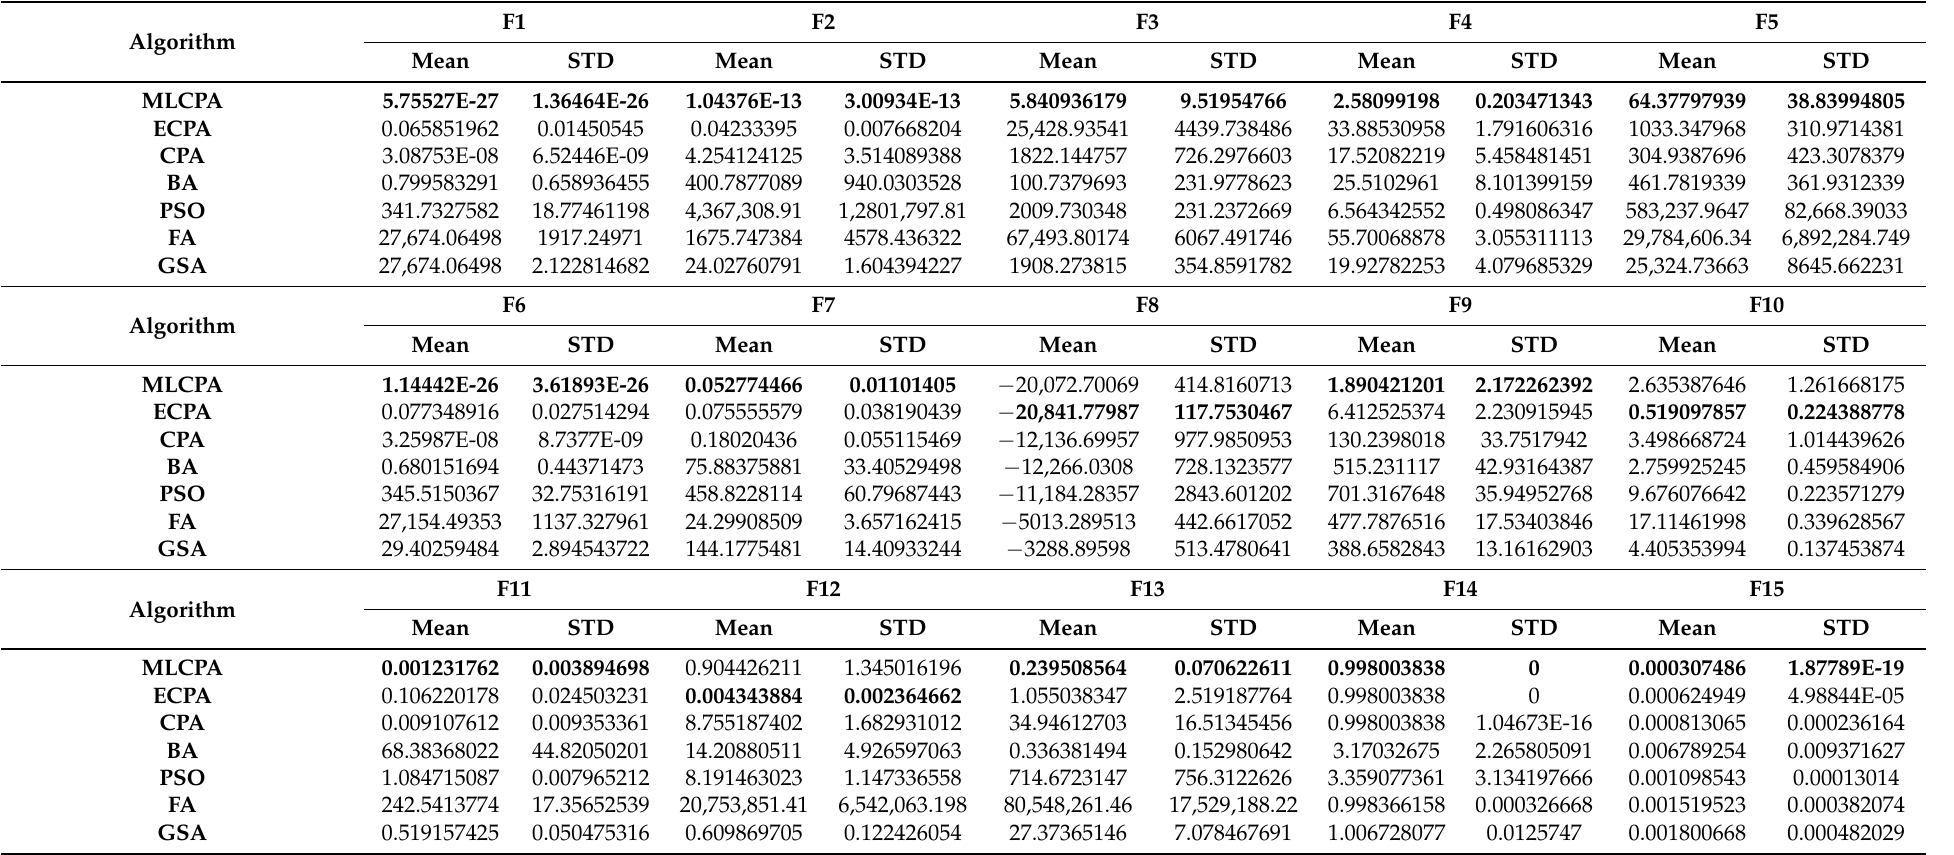
Table 3. Results of benchmark